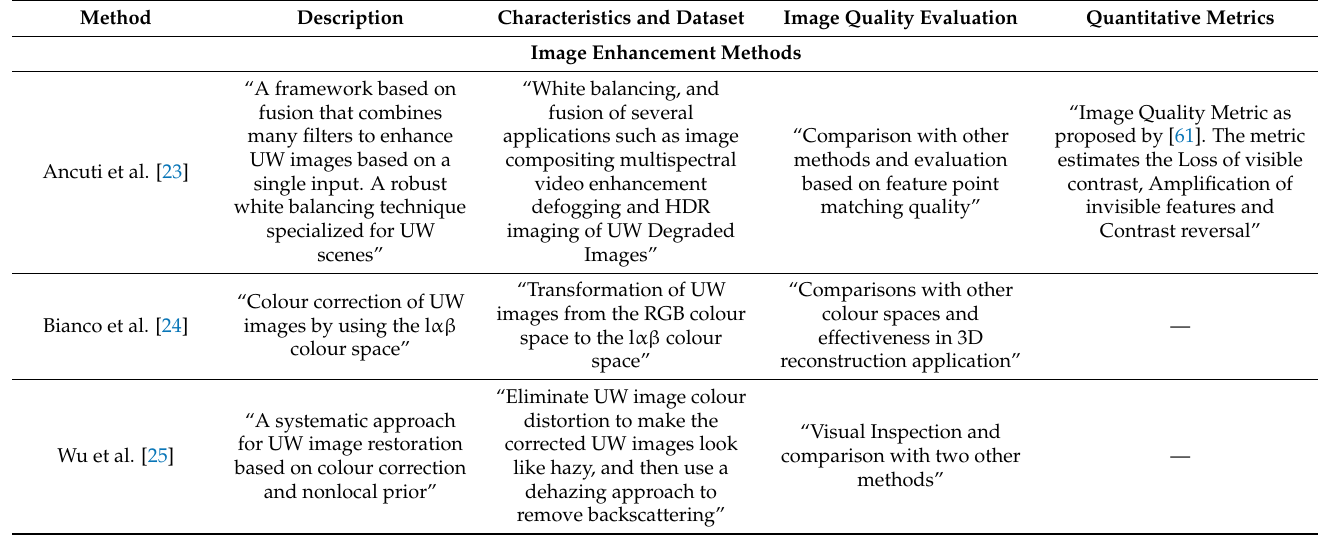
Table 1. Brief description of the main methods described in Section